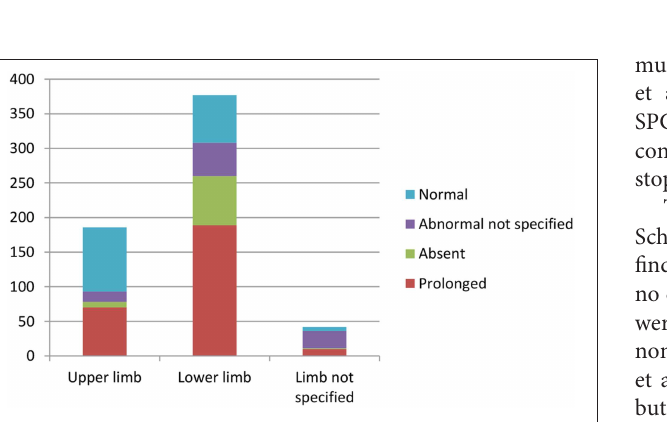
Chart 3 | Summation of studies demonstrating number of patients with abnormal vs. normal central motor conduction times. Data available